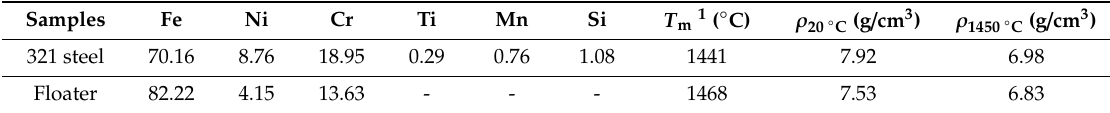
Table 1. Main composition (wt. %) and Physical properties of the samples collected from mold.